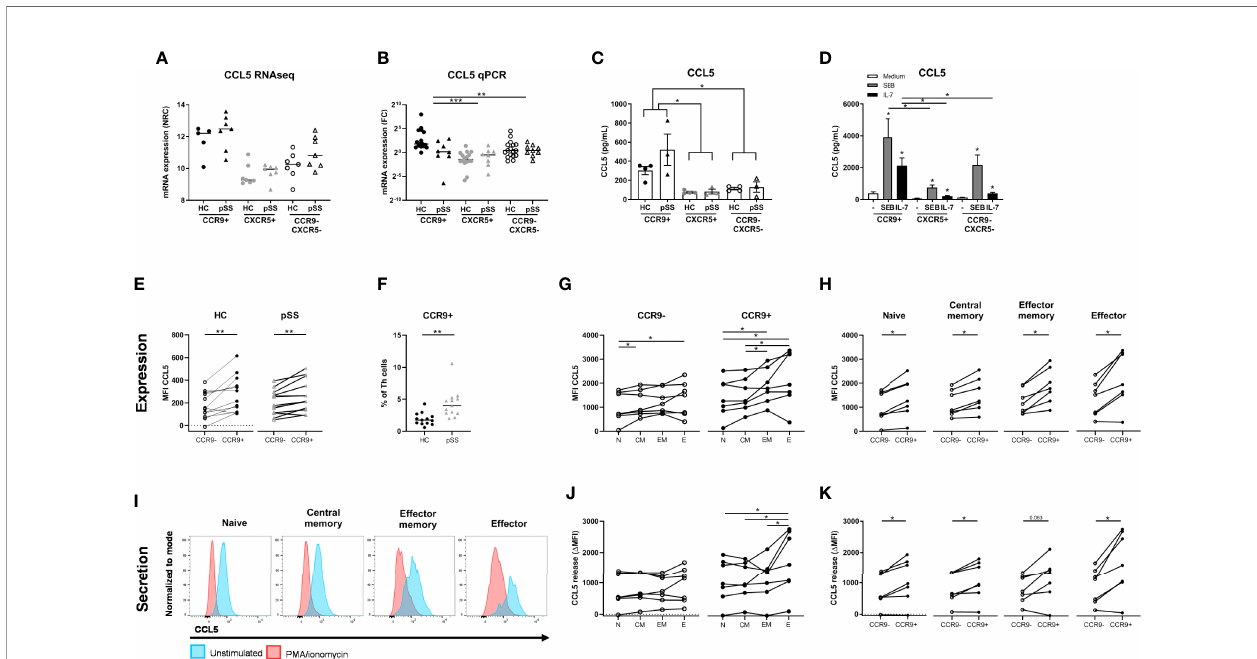
FIGURE 5 | Increased production and release of CCL5 by CCR9+ Th cells in pSS patients and controls is higher in effector cells and is enhanced by IL-7 and antigenic triggering. mRNA expression as assessed by RNA sequencing (A) . In a replication cohort qPCR shows validation of signi fi cantly increased CCL5 mRNA in the CCR9+ Th cell subset as compared to CXCR5+ and CCR9-CXCR5- Th cell subsets (B) . CCR9+, CXCR5+ and CCR9-CXCR5- Th cells from HC (n=4) and pSS patients (n=3) were cultured with monocytes for 72 hours followed by PMA/ionomycin restimulation (C) . To determine the effect of antigen triggering (SEB=Staphylococcal Enterotoxin B) and IL-7 stimulation on CCL5 production by the Th cell subsets we pooled HC and pSS (D) . CCL5 protein expression in Th cells from peripheral blood from healthy controls (n=13) and pSS patients (n=13) was analyzed ex vivo by fl ow cytometry in a 2 nd replication cohort (E) . CCR9 expression on Th cells was also assessed in this replication cohort by fl ow cytometry (F) . In HC CCL5 expression by effector memory and effector Th cells is compared to naive Th cells, both for CCR9- and CCR9+ Th cells (G) ; and in all CD45RO/CD27 compartments CCL5 expression is compared between CCR9- and CCR9+ Th cells (H) . Histograms from a representative donor show CCL5 expression upon 4h of stimulation with PMA/ionomycin in the different Th cell compartments. Blue and red shows CCL5 expression in unstimulated and PMA/Ionomycin stimulated cells, respectively (I) . CCL5 release expressed as the difference between unstimulated – the stimulated cultures (delta) between all four CD45RO/CD27 compartments for both CCR9- and CCR9+ Th cells (J) and within each compartment comparing CCR9- and CCR9+ Th cells (K) . FC: fold change. Th cell phenotypic validation: naive (CD27+CD45RO-), central memory (CD27+CD45RO+), effector memory (CD27-CD45RO+), effector (CD27-CD45RO-) cells. MFI: mean fl uorescence intensity. D MFI: deltaMFI (unstimulated minus PMA/ionomycin stimulated). *, **, *** indicates statistical signi fi cance of p<0.05, 0.01, 0.001,